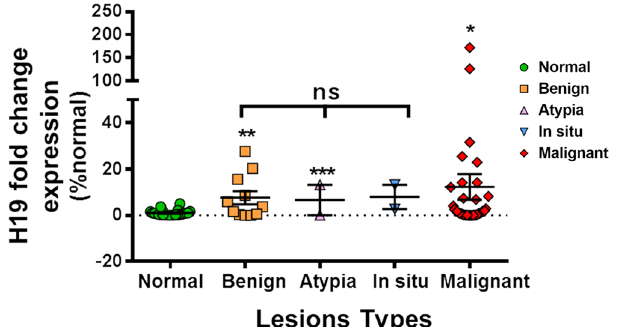
Figure 2. Three different intervals of H19 expression accordingly with three classes of cancer degeneration. H19 fold change expression levels in benign biopsies were the lowest (7.6 ± 2.85) followed by atypia and in situ lesions H19 fold change levels, while malignant lesions showed the highest H19 fold change expression (12.3 ± 5.5). Expression levels were normalized to GAPDH expression. Results were expressed as means ± SEM. ANOVA and t-test, *p < 0.05, **p < 0.01, ns p > 0.5.